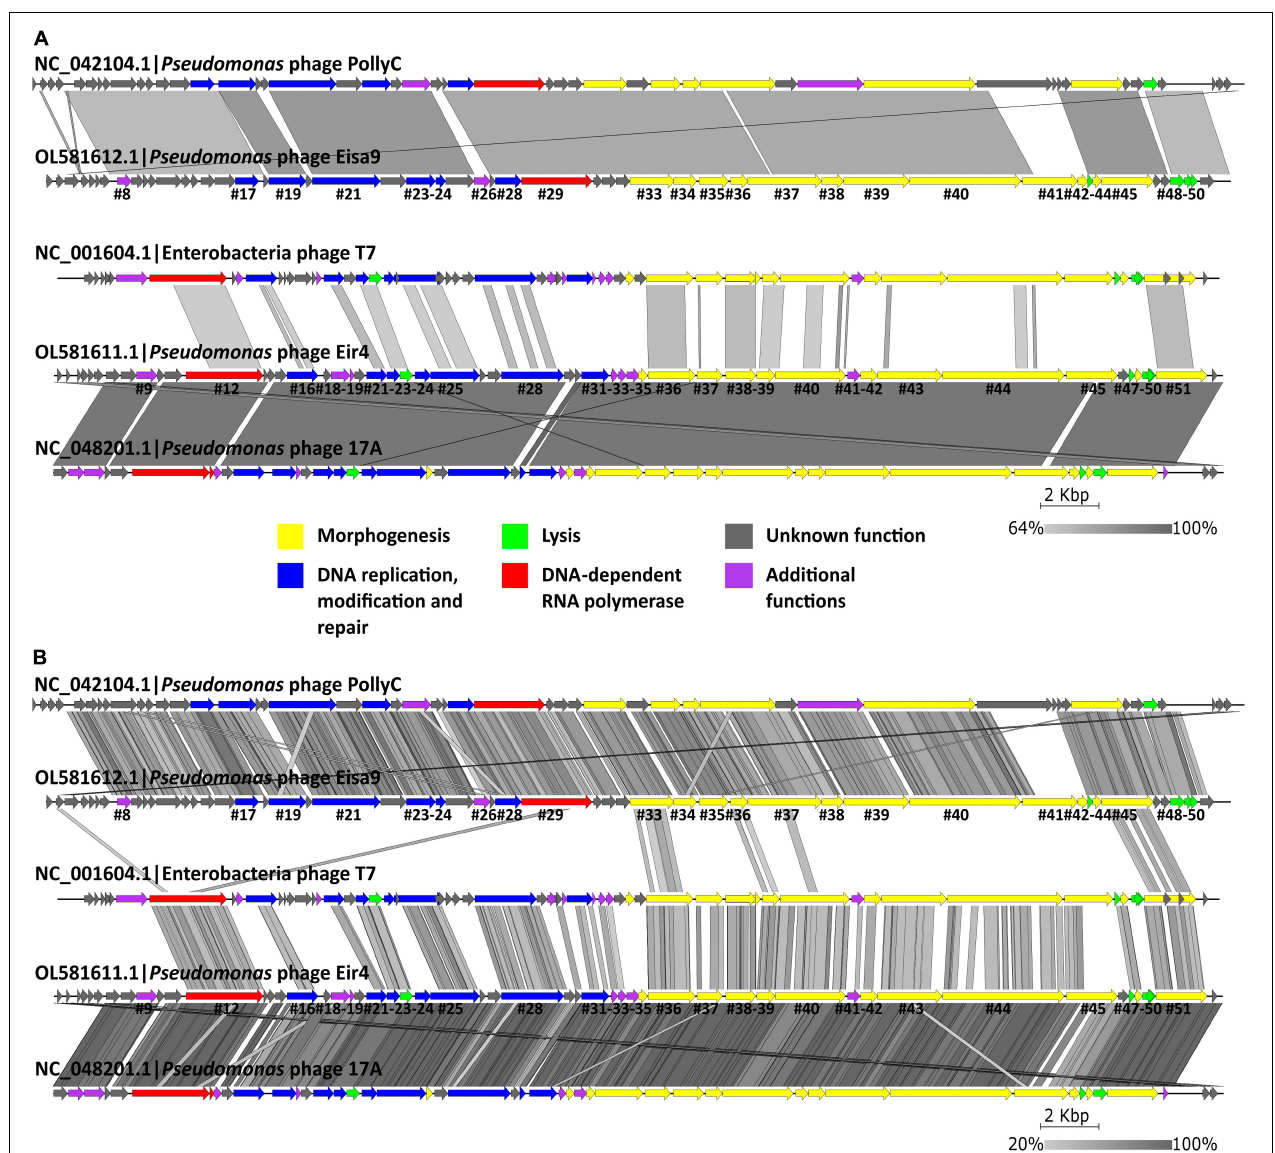
FIGURE 2 | Pairwise genome nucleotide sequence comparison of Pseudomonas phages Eir4 and Eisa9, their respective closest-known relatives with standing in the current phage taxonomy, as well as an exemplar Autographiviridae phage T7 using BLASTN (A) and TBLASTX (B) . Genome representations are drawn to scale with the scale bar indicating 2,000 bp. Arrows represent ORFs and point in the direction of transcription. Color coding is based on the functional groups of the respective ORF putative products according to the legend, and ORFs of Eir4 and Eisa9 with functional prediction are annotated by the order of their appearance in the genome ( Supplementary Tables 1 , 2 ). Gray boxes represent regions of similarity between the genomes and are colored in gradient, with darker shades of gray representing higher region identity. The figure was generated using Easyfig (Sullivan et al.,